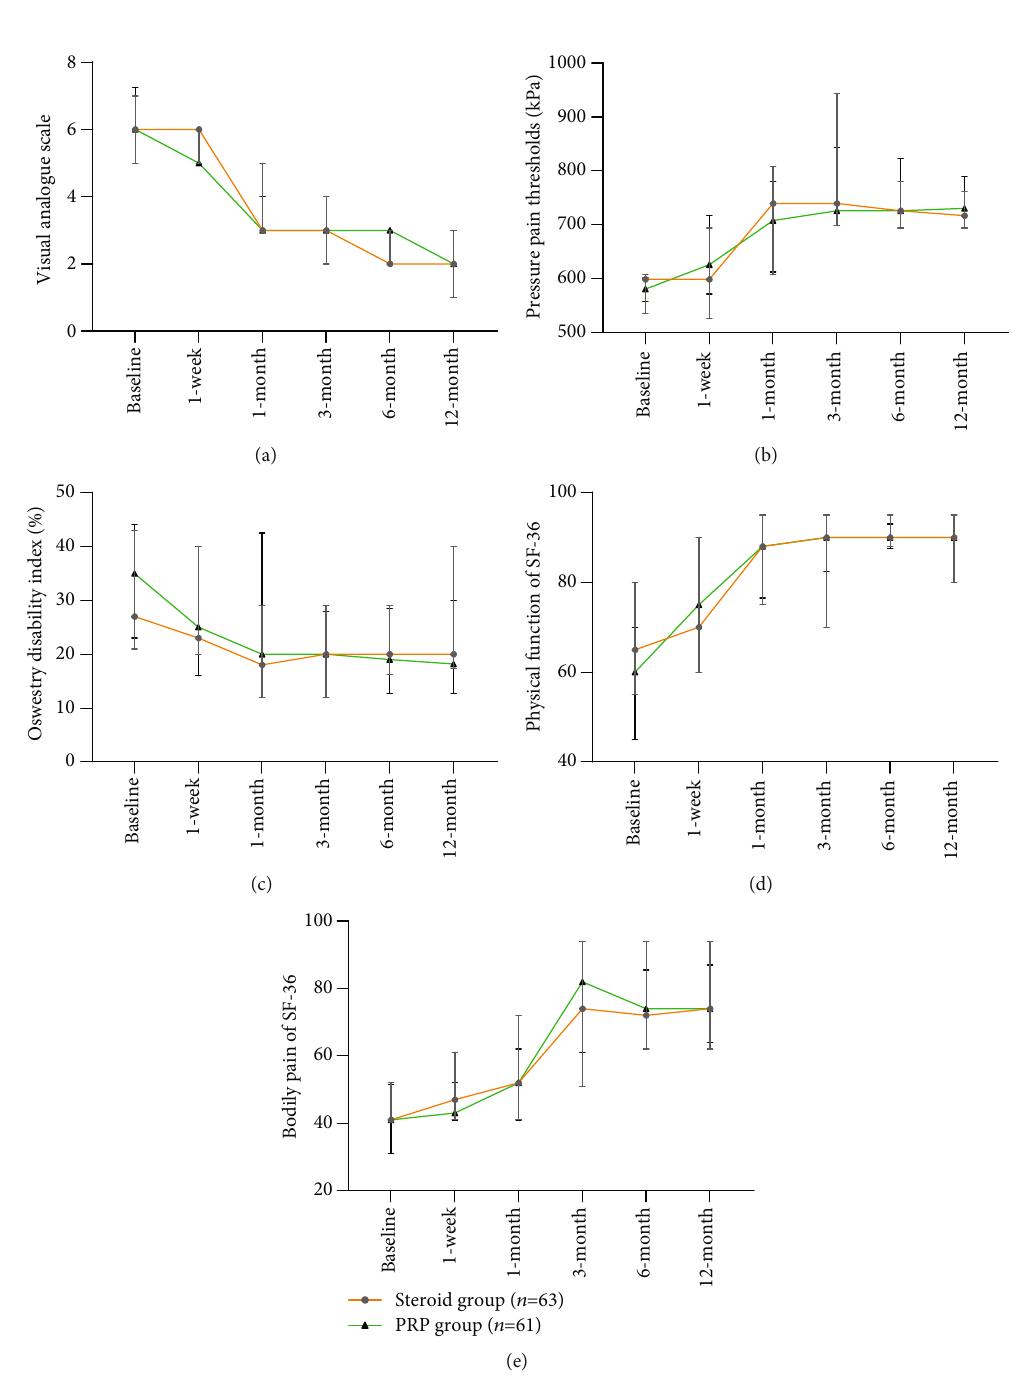
Figure 3: Comparison of patient-reported outcomes between the PRP ( n = 61 ) and steroid ( n = 63 ) groups over time (median, quartile). There was no signi fi cant di ff erence in the (a) visual analogue scale, (b) pressure pain thresholds, (c) Oswestry disability index, and (d) physical function and (e) bodily pain domains of the 36-item short form health survey (SF-36) between the PRP group and the steroid group during follow-ups over the course of one year. The error bars represent the 1st quartile and the 3rd